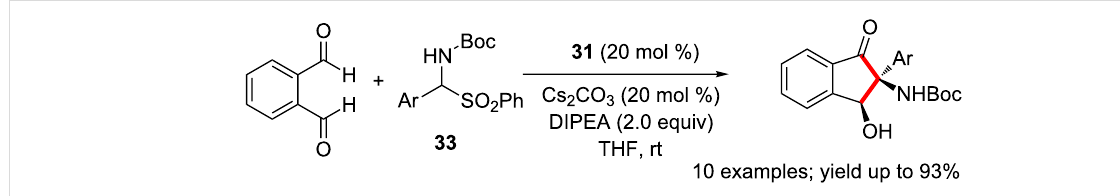
Scheme 19: NHC-catalysed diastereoselective synthesis of cis -2-amino 3-hydroxyindanones.